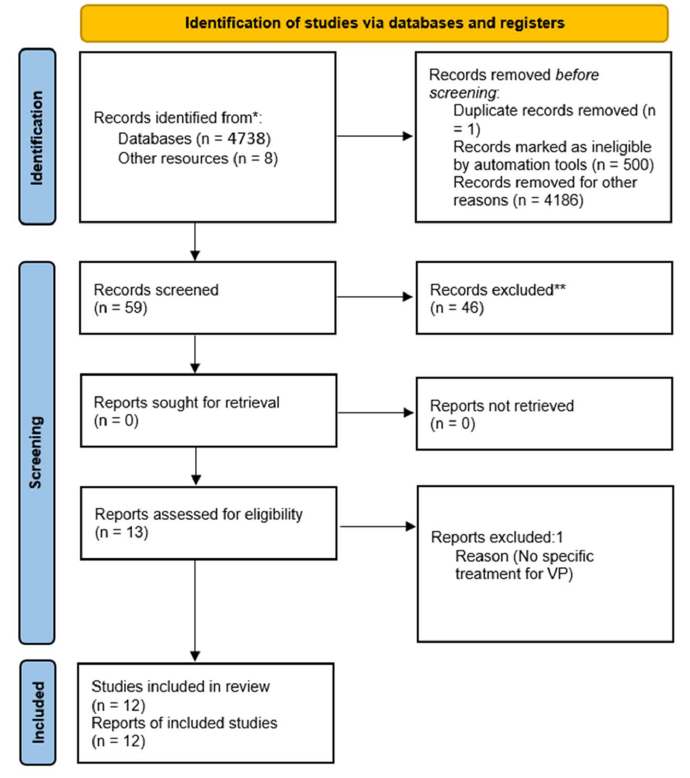
Figure 1. PRISMA Flow Diagram. * Pubmed, Scopus and Web of Science electronic databases. **